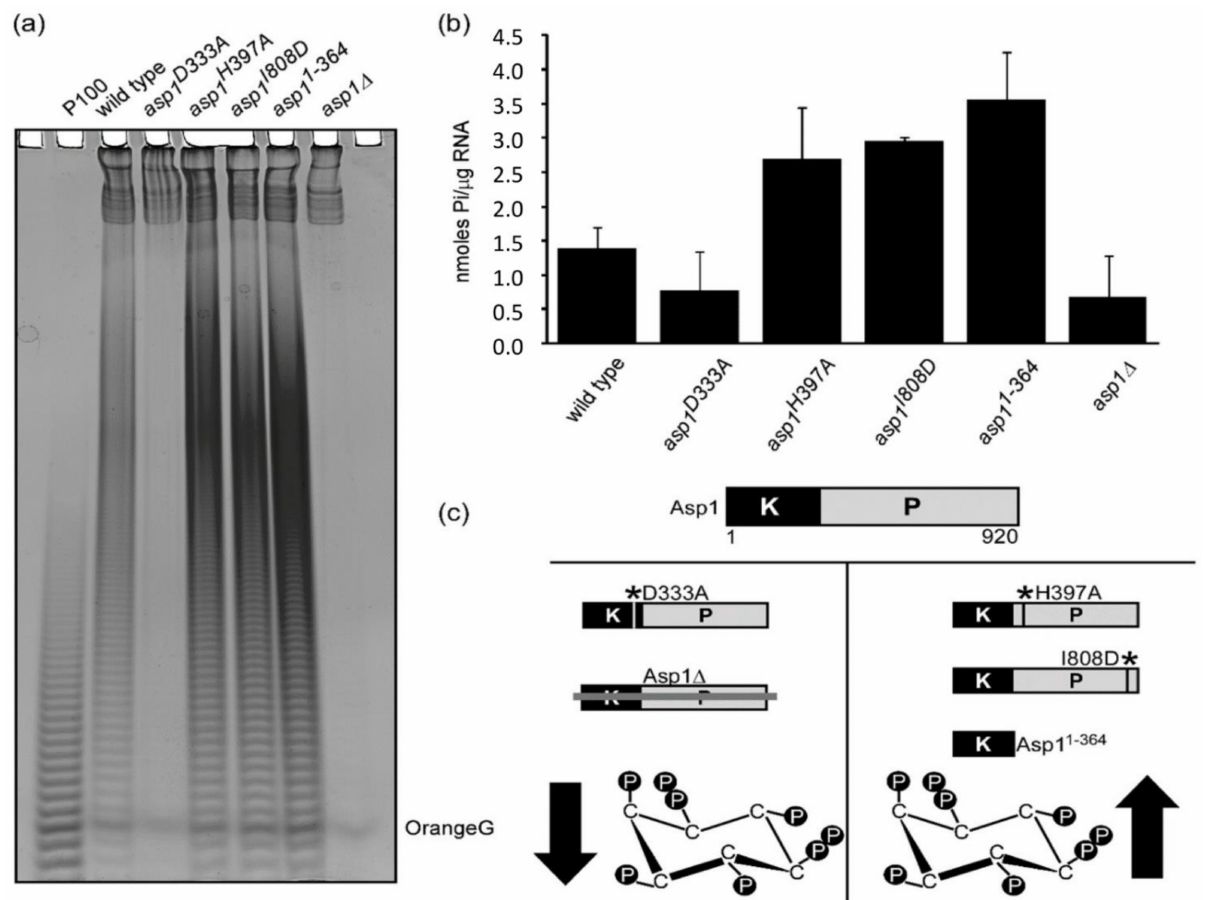
Figure 3. Asp1 generated IP 8 modulate polyP synthesis in a dose dependent manner. ( a ) Asp1 generated IP 8 regulate cellular polyP levels. S. pombe polyP detected as a dark smear by PAGE analysis of lysates of the wild-type, asp1 D333A , asp1 H397A , asp1 I808D , asp1 1 − 364 , and asp1 ∆ strains. ( b ) quantification of polyP levels shown in ( a ) by Malachite Green assay. ( c ) schematic representation of the correlation between Asp1 pyrophosphatase activity and IP 8 levels in S. pombe . All Asp1 variants are expressed endogenously instead of the WT Asp1. asp1 ∆ and asp1 D333A strains have no IP 8 , while strains asp1 H397A , asp1 I808D , and asp1 1 − 364 generate more IP 8 than the wild-type strain. * denotes position of mutation in Asp1